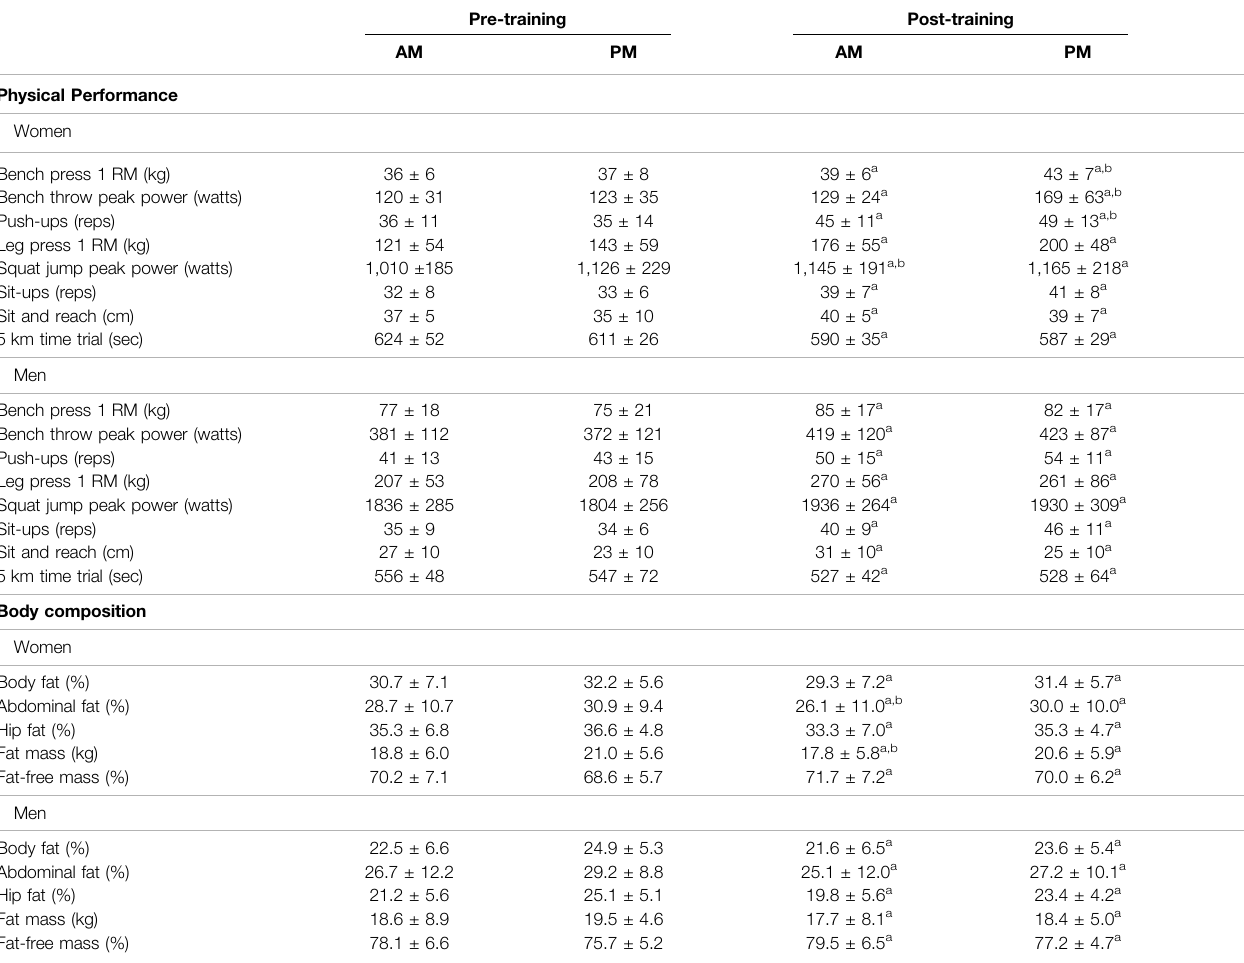
TABLE 3 | Physical performance and body composition changes between AM vs PM exercisers during the 12-weeks RISE Exercise Intervention for women and men.